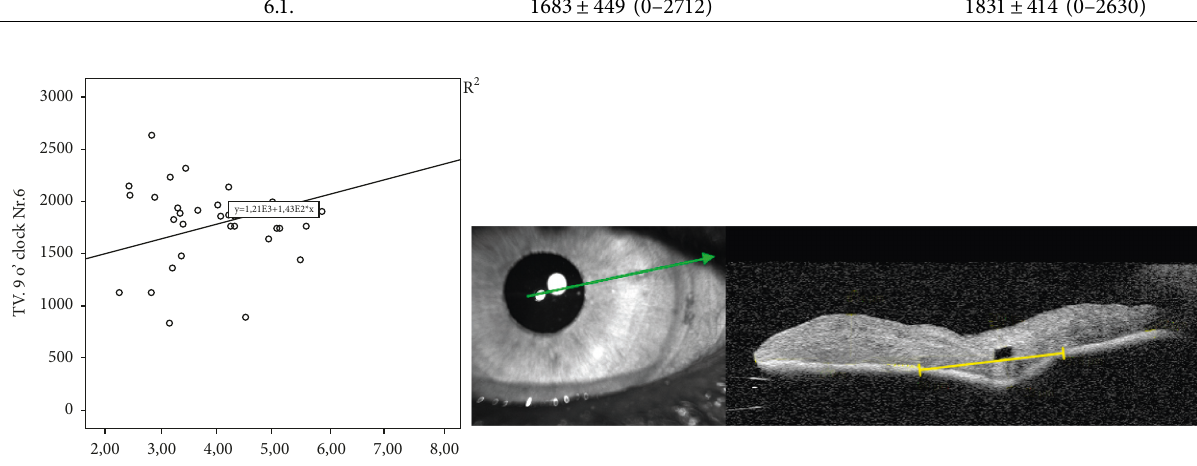
Figure 4: Relationship between anterior chamber depth and width of the posterior deflection of the iris tissue behind the IOL haptic shown with Pearson’s correlation and the corresponding OCT picture of the measuring point (transversal).